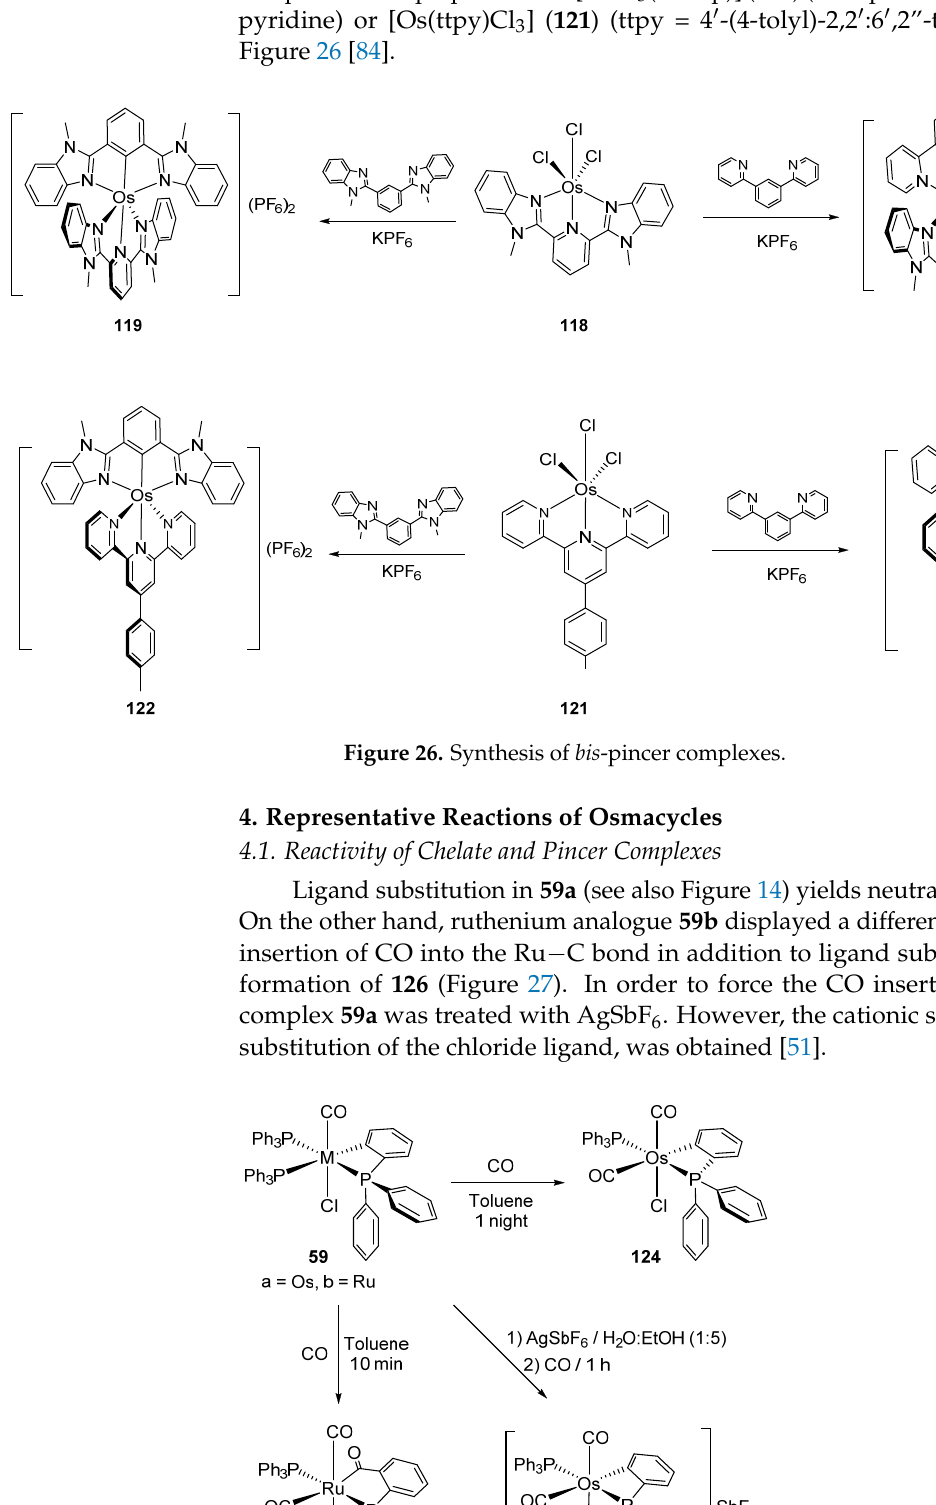
Figure 27. Reactions of four-membered metalacycles.